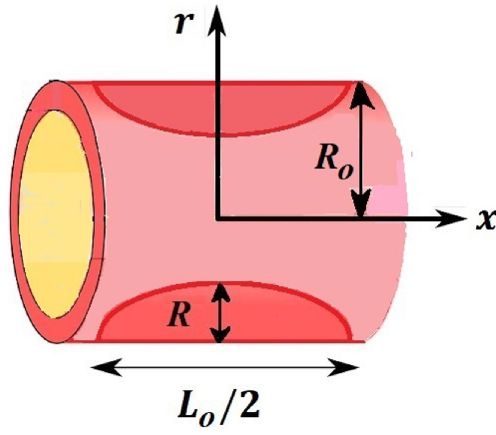
Figure 1. Geometrical structure of artery with stenosis.